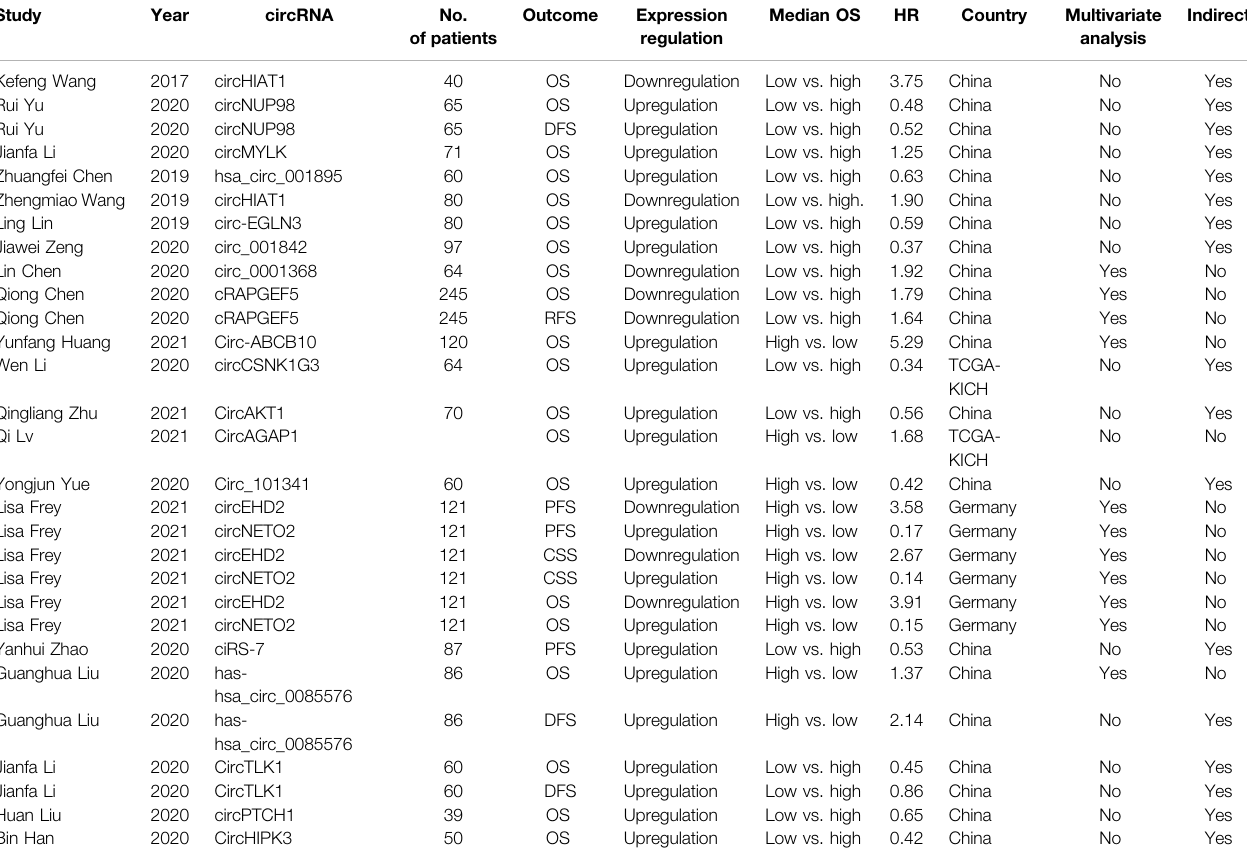
TABLE 1 | Characteristics of the included studies.